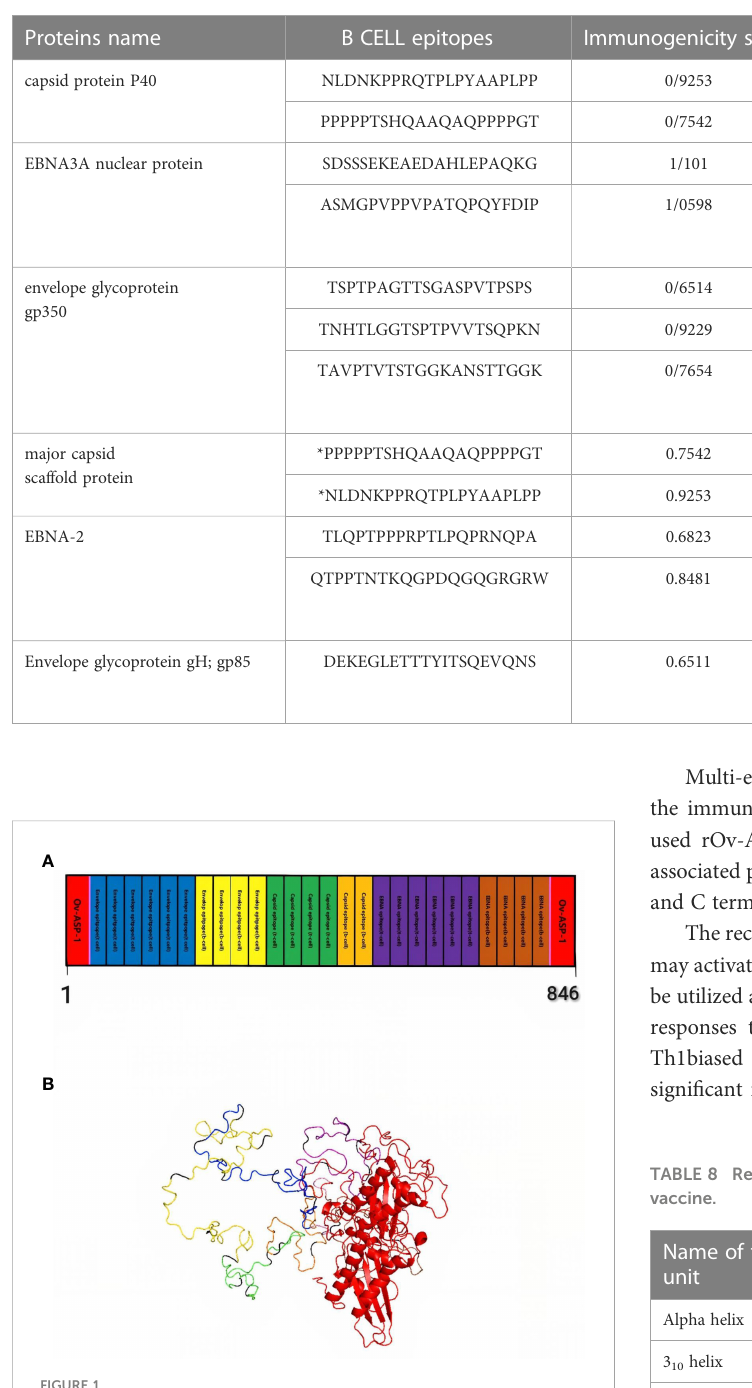
FIGURE 1 Schematic representation of multi-epitope vaccine. The vaccine consists